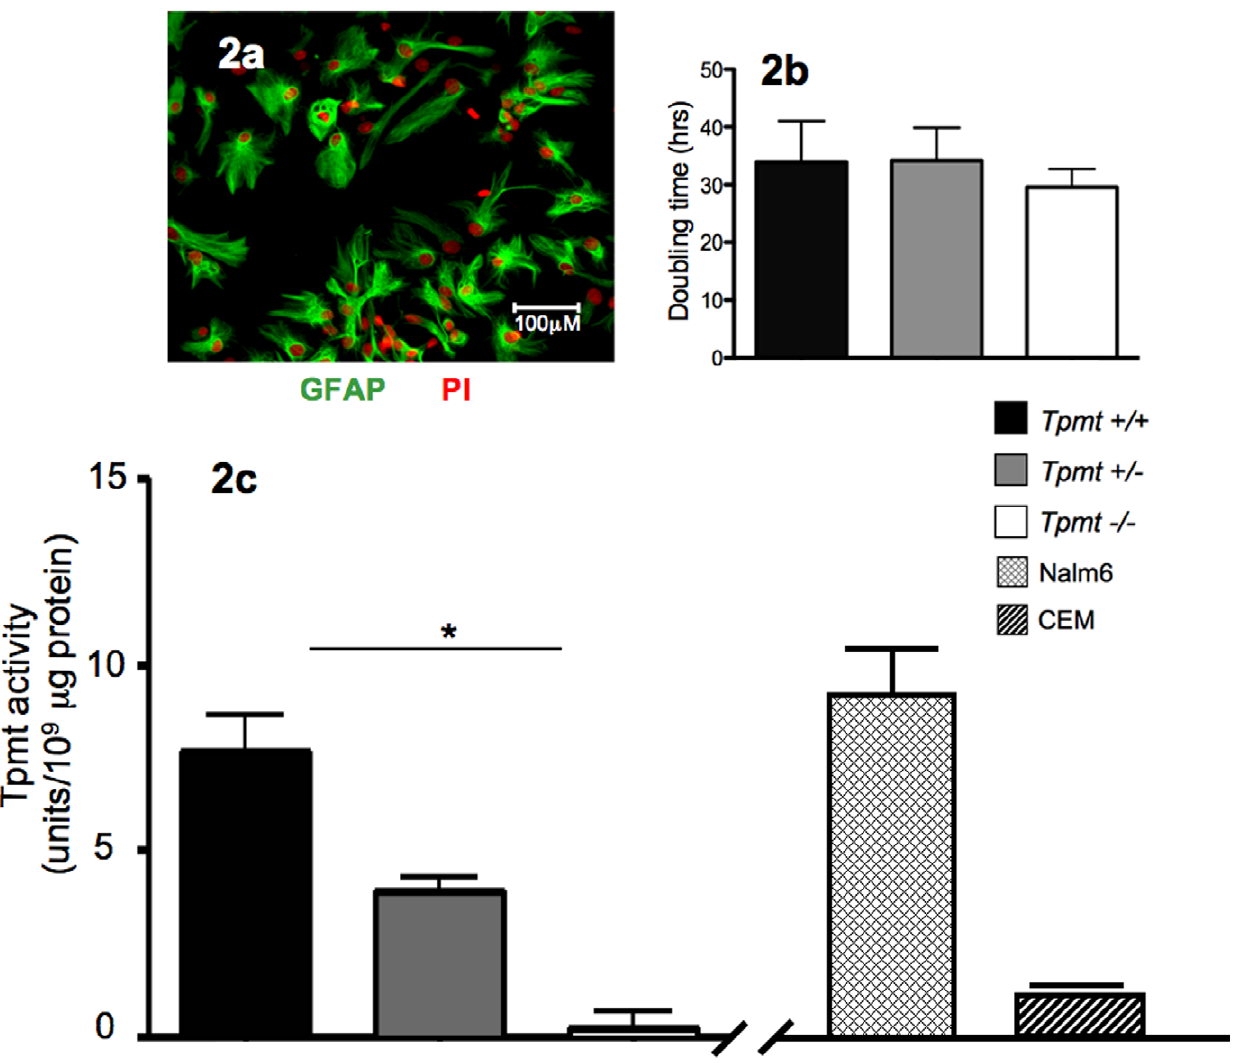
Figure 2. Characterization of Tpmt + / + , Tpmt + / 2 , and Tpmt 2 / 2 primary astrocyte cultures. (a) Micrograph image (200 6 ) of primary astrocytes showing high astrocyte purity determined by GFAP (green) and propidium iodide (red) fluorescent staining. (b) There was no significant difference in growth rates between astrocyte cultures of each Tpmt genotype (p=0.89). (c) The level of Tpmt protein activity was significantly different between the three Tpmt genotypes (p=0.018); and levels were comparable to Nalm6 and CEM control lymphoblastoid cell lines. Bars represent the means; whiskers represent the standard deviation ( 6 ); * p , 0.05.